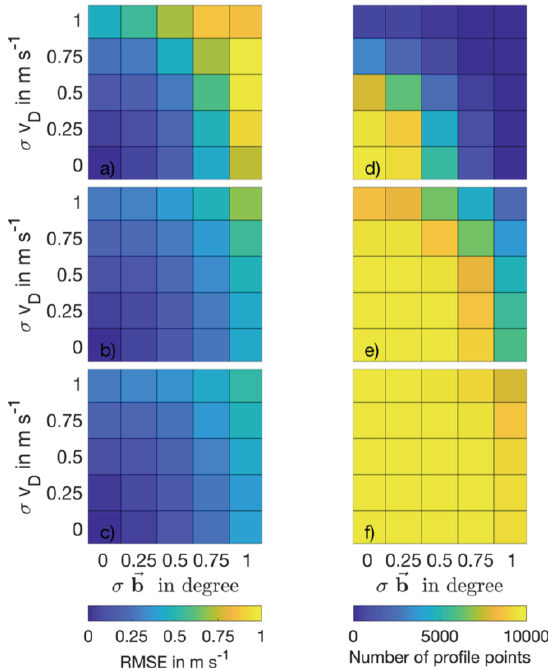
Figure 4: Retrieval error due to emulated noisy measurement system. a), d) 5 m s -1 ; b), e) 10 m s -1 ; c), f) 15 m s -1 background wind speed